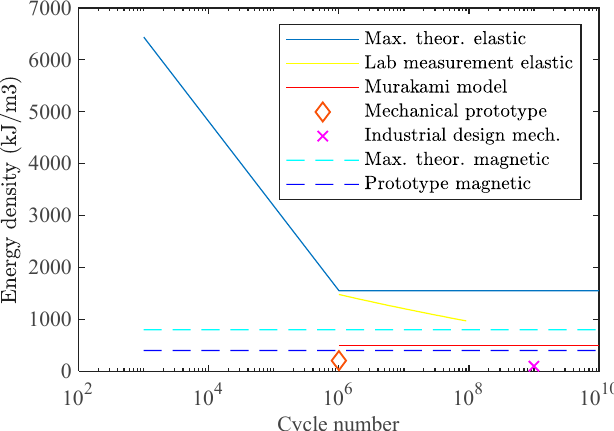
Figure 13. Benchmarking magnetic springs vs. mechanical springs; magnetic springs have increasingly higher energy density for high life cycle numbers.